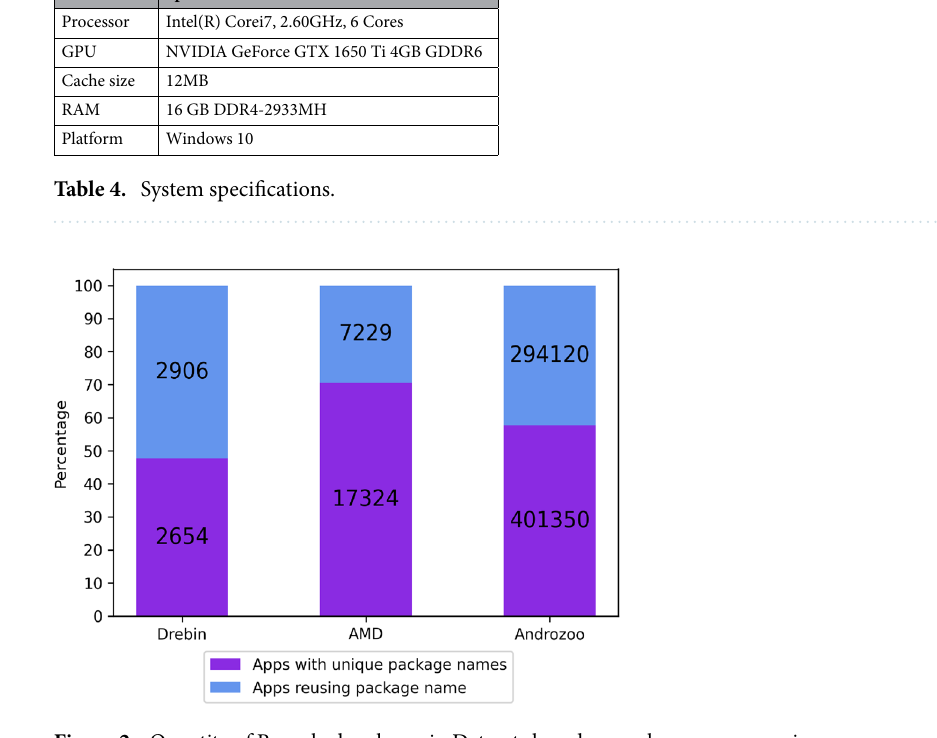
Figure 2. Quantity of Repacked malware in Datasets based on package names reusing.